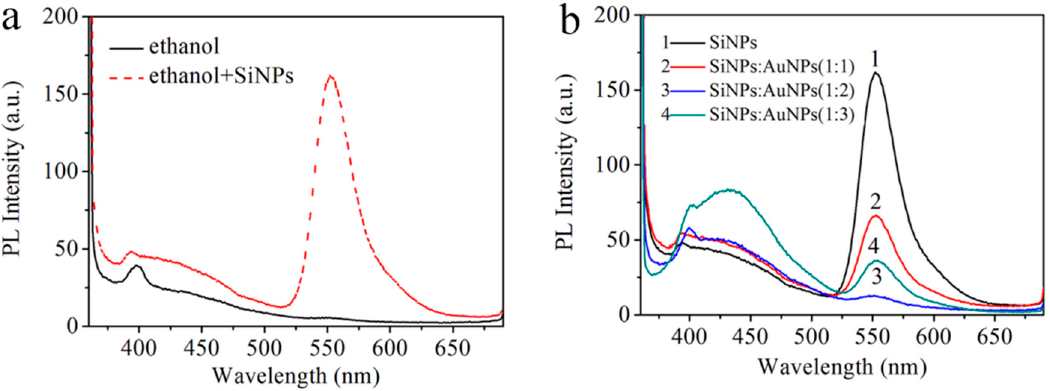
Figure 4. ( a ) Fluorescence emission spectra of ethanol and SiNPs-ethanol; ( b ) Fluorescence emission spectra of SiNPs and AuNPs at different volume ratios ( λ ex : 350 nm, λ em : 550 nm).